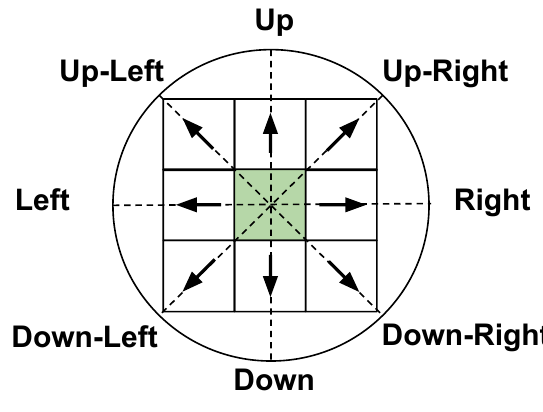
Figure 7. All actions available to generate the Q-Table. This figure is related the real world (the positions into the circle) to the simulate world used on the algorithm to create the trajectory